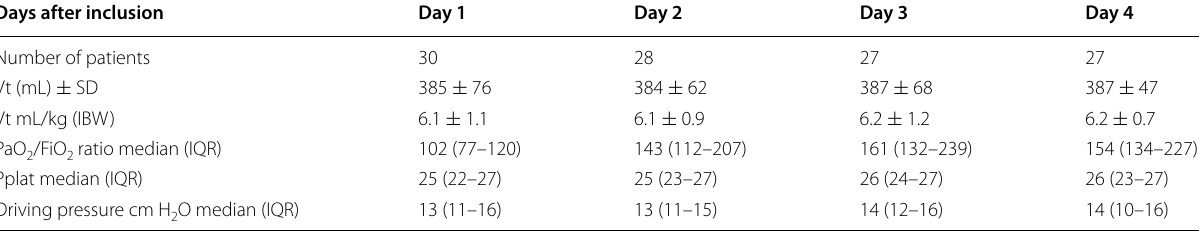
Table 2 Evolution of ventilatory parameters and blood gas exchange from day 1 to day 4 Days after inclusion Day 1